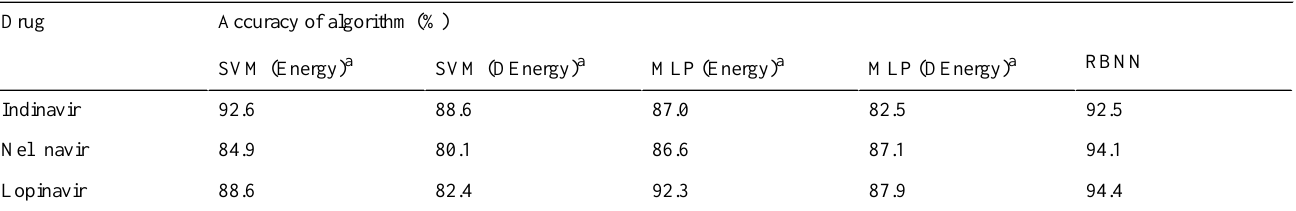
Table 3. Accuracy of predicting ARV drug resistance using the interpretation algorithms, support vector machines (SVM), multilayer perceptrons (MLP), and radial basis neural networks (RBNN) [29].